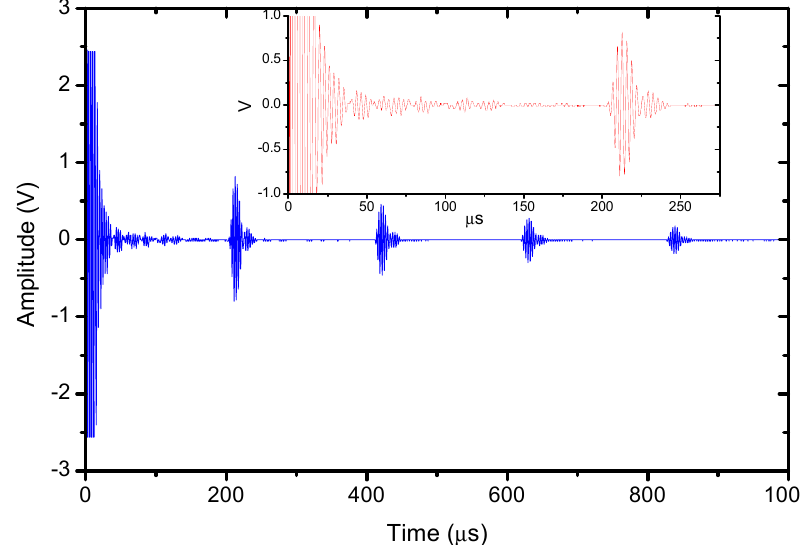
Figure 10. Transducer response in pulse-echo with the 1–3 connectivity piezocomposite layer.